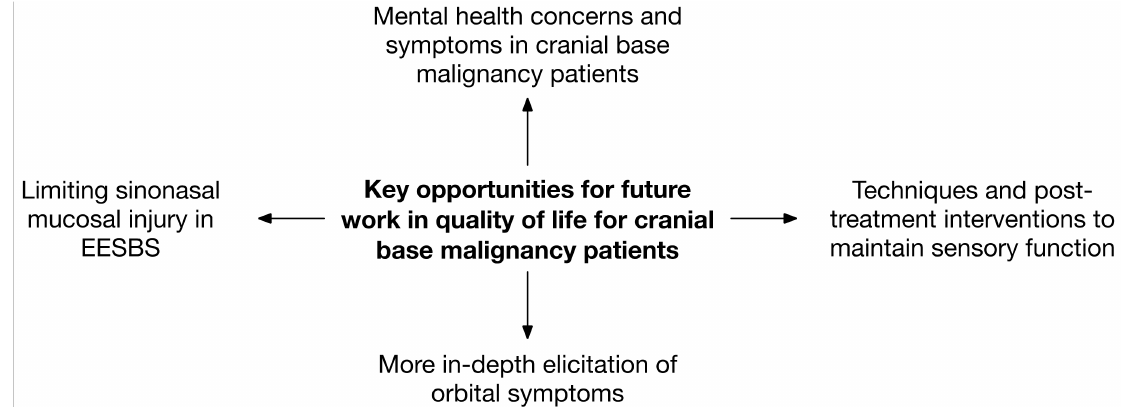
Figure 1. Major opportunities for future work in quality-of-life considerations for patients with anterior cranial base